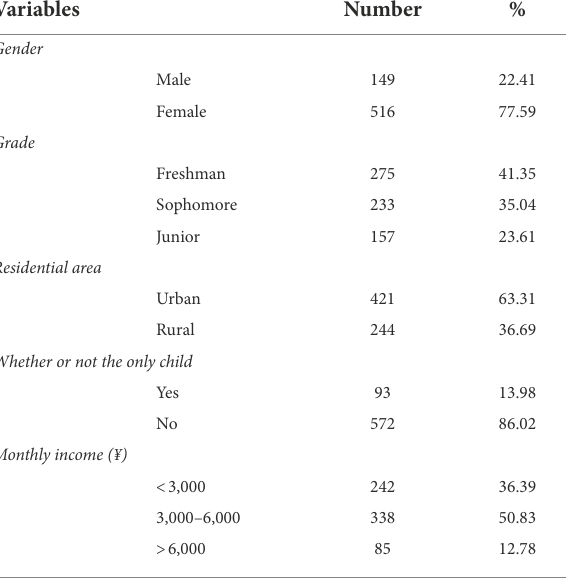
TABLE 1 Demographic characteristics of the study participants ( N =